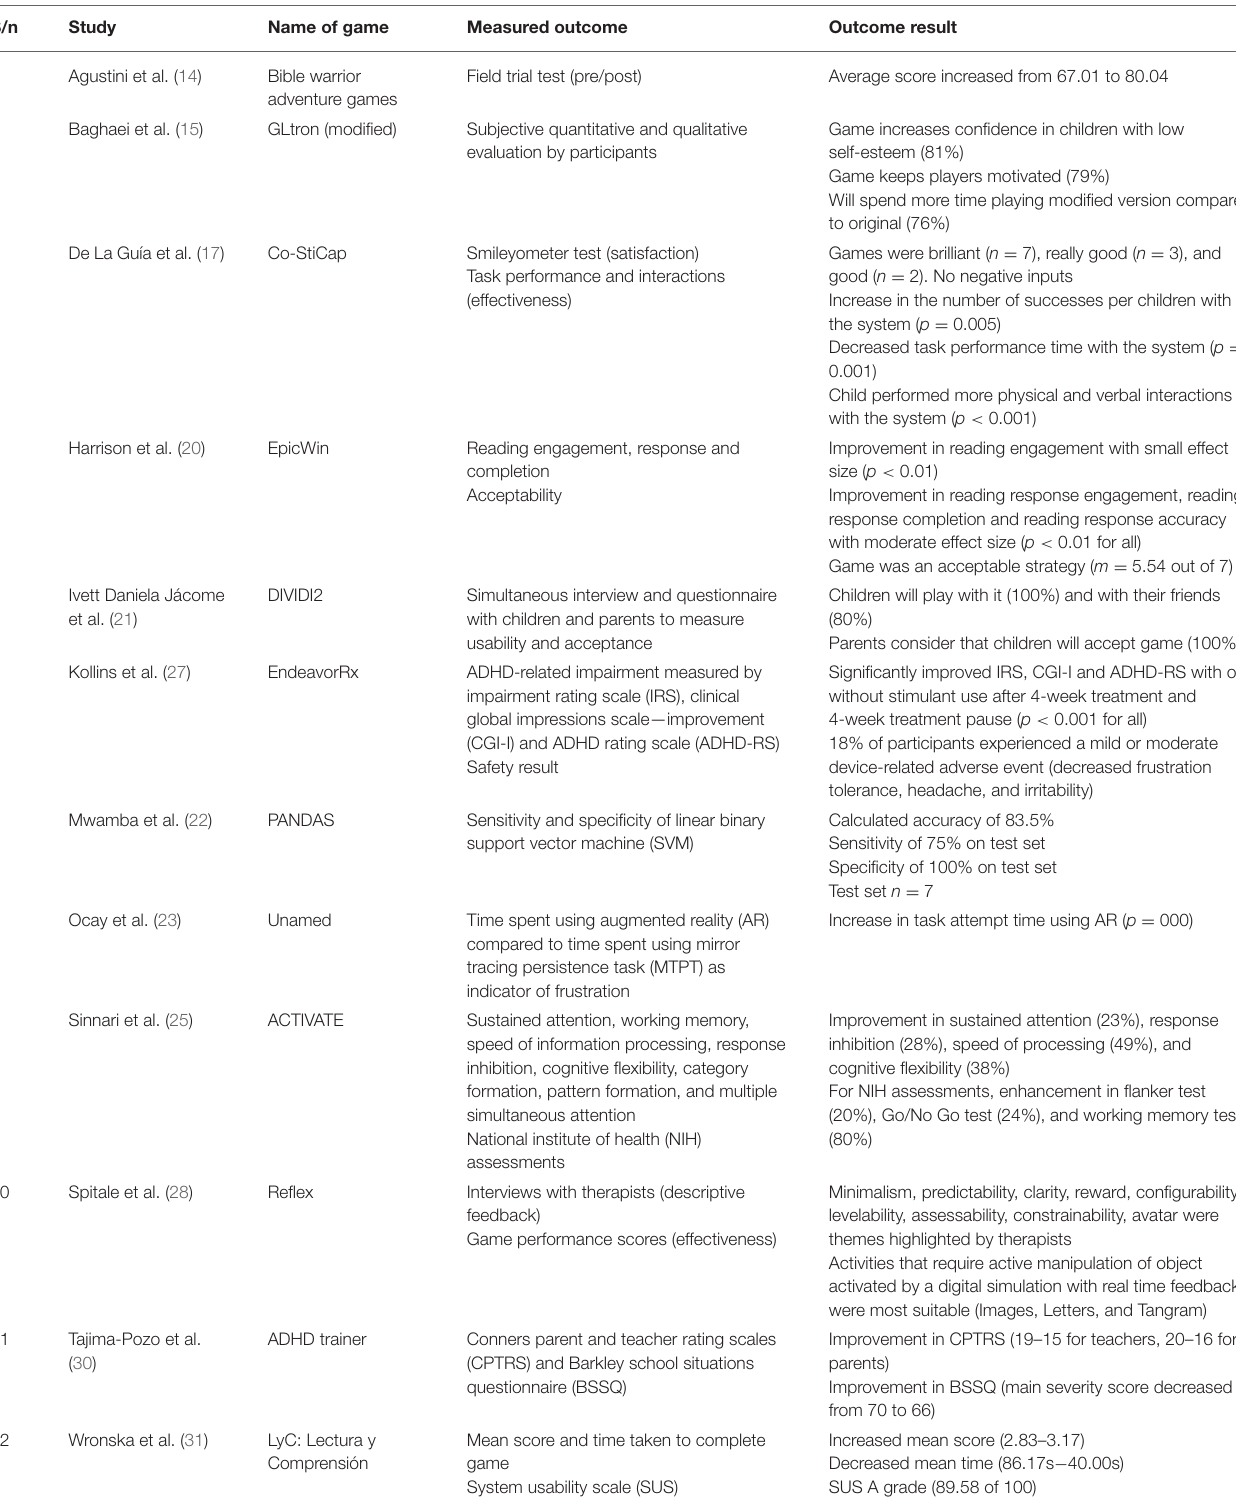
TABLE 3 | The measured outcome and the results that employed gamified